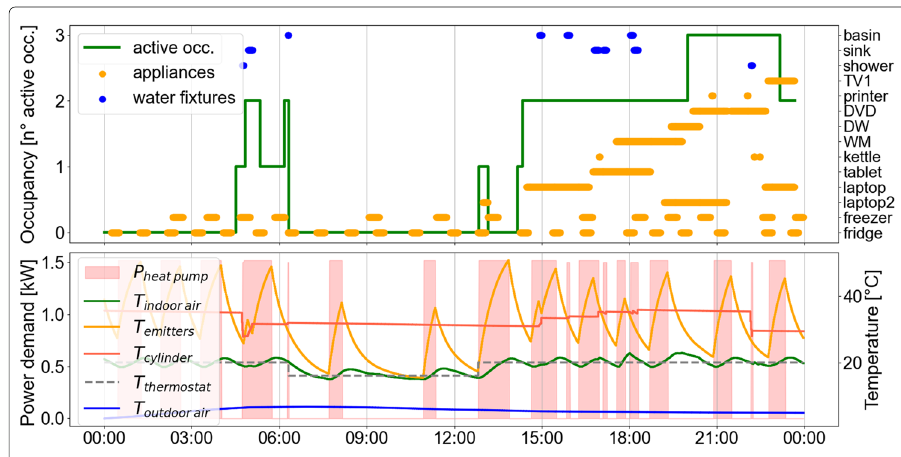
Fig. 3 Example of simulation output for a single day in winter. DW=dish washer; WM=washing